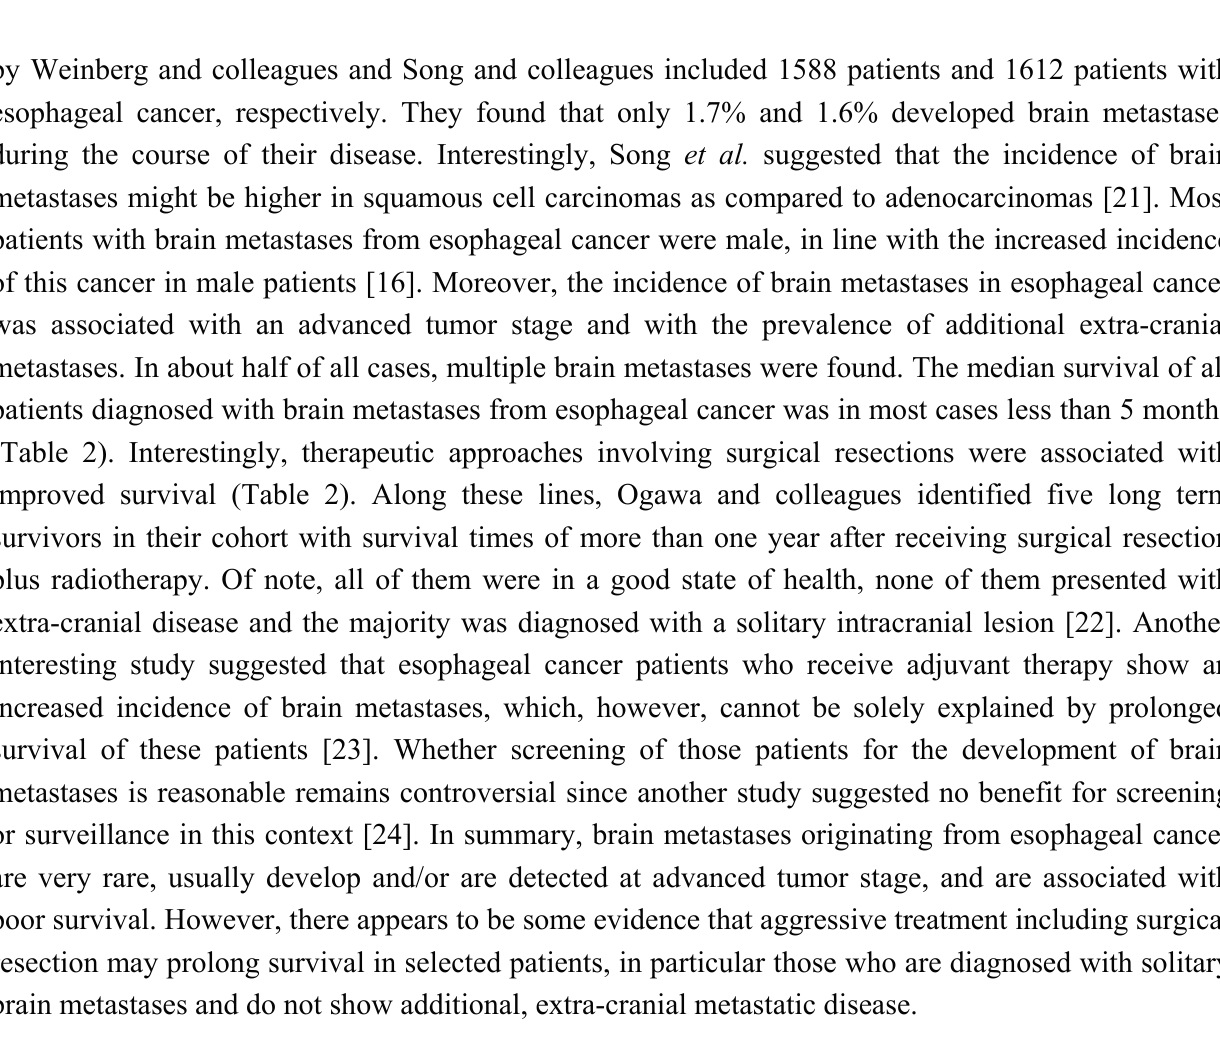
Table 2. Clinical studies analyzing characteristics and survival of patients diagnosed with brain metastases originating from esophageal